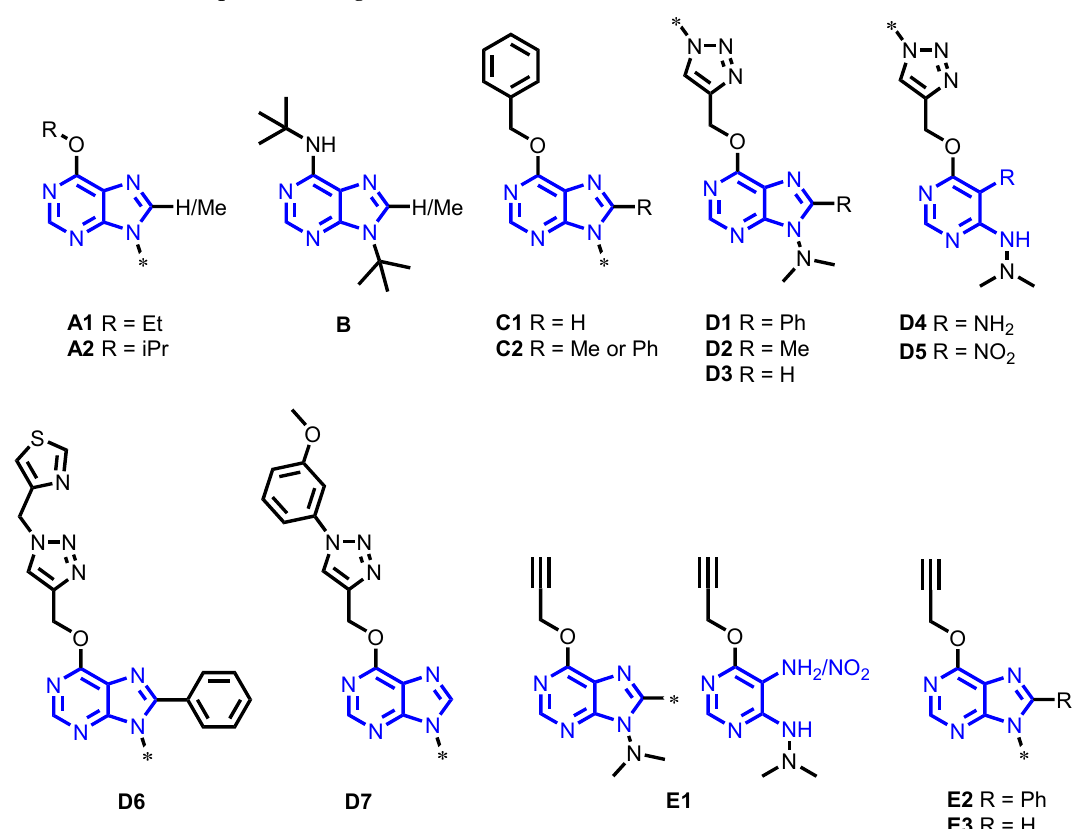
Figure 1. Chemical structures and classifications of the evaluated compounds. Letters A–E identify the five different chemical groups (scaffolds), while their accompanying numbers depict scaffold subgroups (see Section 4.1 for further details). *, indicates different chemical substituents.